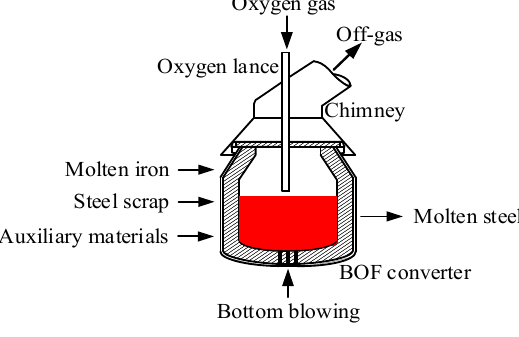
Figure 1. The schematic representation of BOF steelmaking.